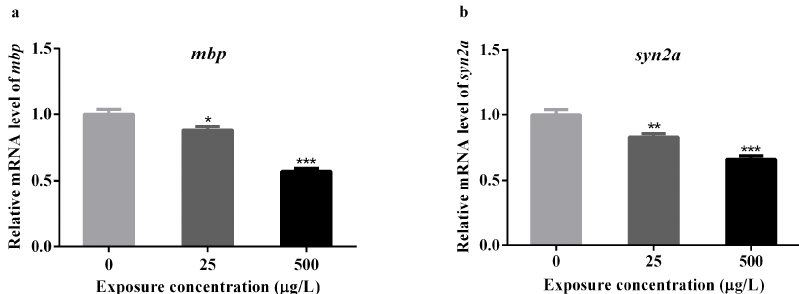
Figure 5. The mRNA levels of two genes associated with neural development in the zebrafish larvae exposed to several concentrations of methamidophos at 72 hpf. The expression levels of the mbp ( a ) and syn2a ( b ) genes were both significantly down-regulated in the 25 and 500 μ g/L exposure groups, compared with the control group. * p < 0.05; ** p < 0.01; *** p < 0.001.